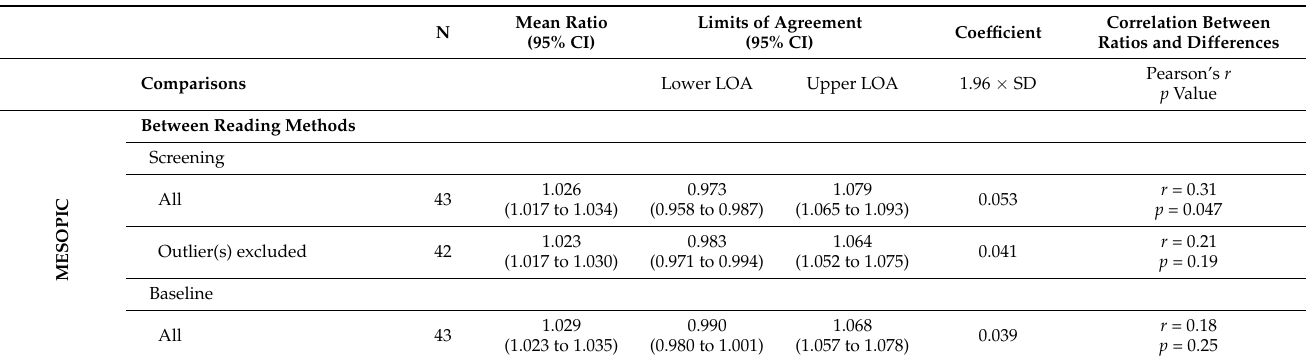
Table 3. Reproducibility of mesopic pupil size measurements between human-assisted and automated readings using ratios.